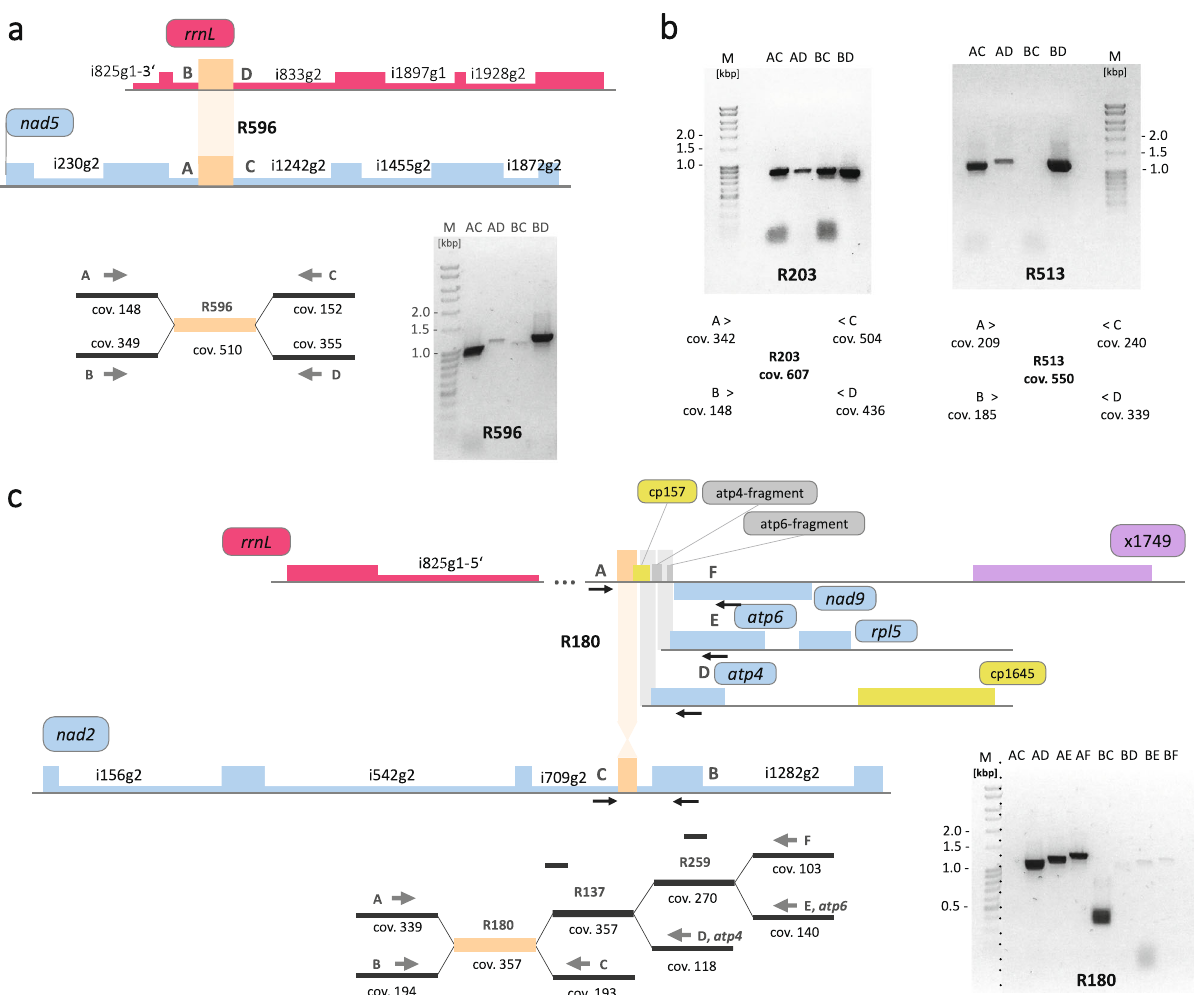
Fig. 4 Repeats and recombination in the Haplopteris ensiformis mitogenome. Recombinations across repeats (in orange) R596 (A), repeats R203 and R 513 (B) and R180 (C) was investigated by tsa-PCR ( ” template-switch-avoiding ” ) strategies. a R596 is identically present in domains IV of group II introns nad5i1242g2 and rrnLi833g2. Average read coverage of the fl anking single copy regions were ca. 150× for nad5 (arrangement A-C) and ca. 350× for rrnL (arrangement B-D), apparently adding up to ca. 500× for R596. PCR products are obtained for the expected gene continuities (AC, BD) with only minor evidence for reciprocal exchanges (AD, BC). b All combinations of fl anking sequences (AC-BD) are identi fi ed for recombination across R203 whereas a clear bias is seen for recombination across R513 where a product for primer combination B-C remains undetected. c One copy of repeat R180 is located in intron nad2i709g2, another one downstream of the nad9 gene. The region between R180 and nad9 contains additional repeats R137 and R259 and all consecutive recombination products can be found whereas there is only very weak evidence for recombination across the R180 copy located in nad2i709g2. The marker lane of the electrophoresis gel covering R180 has been rearranged as indicated by the dotted line. The images of electrophoretic gels used in this fi gure are deposited as supplementary fi gures 5a and